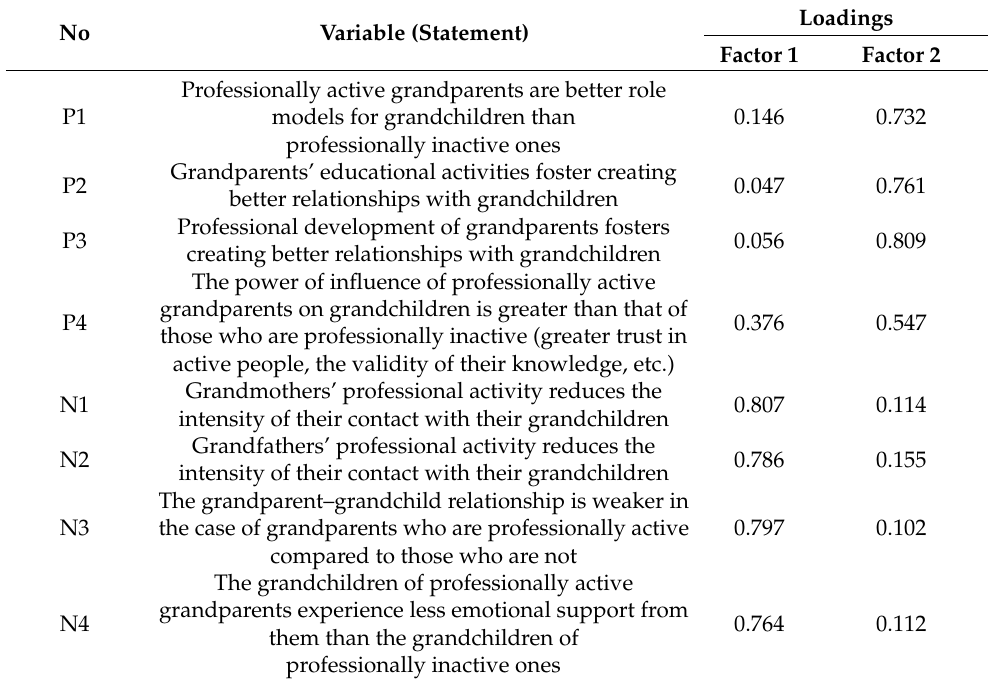
Table 5. Factor analysis results—factor loadings after varimax rotation with Kaiser normalization.